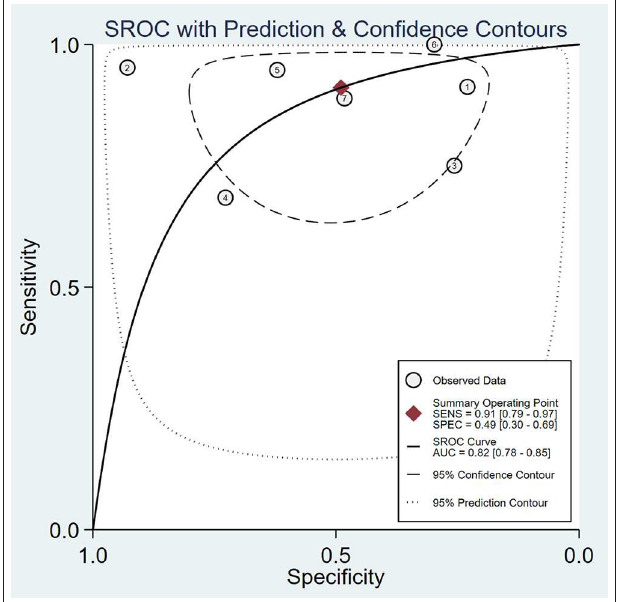
FIGURE 2 | Summary receiver-operating characteristic curve (SROC) curve of micro-ultrasound area under the curve (AUC).